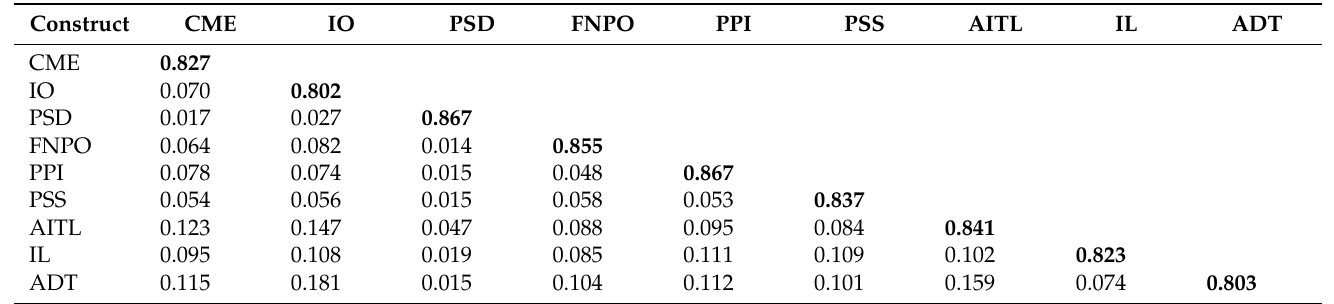
Table A5. Discriminant reliability as suggested by Fornell and Larcker (1981).